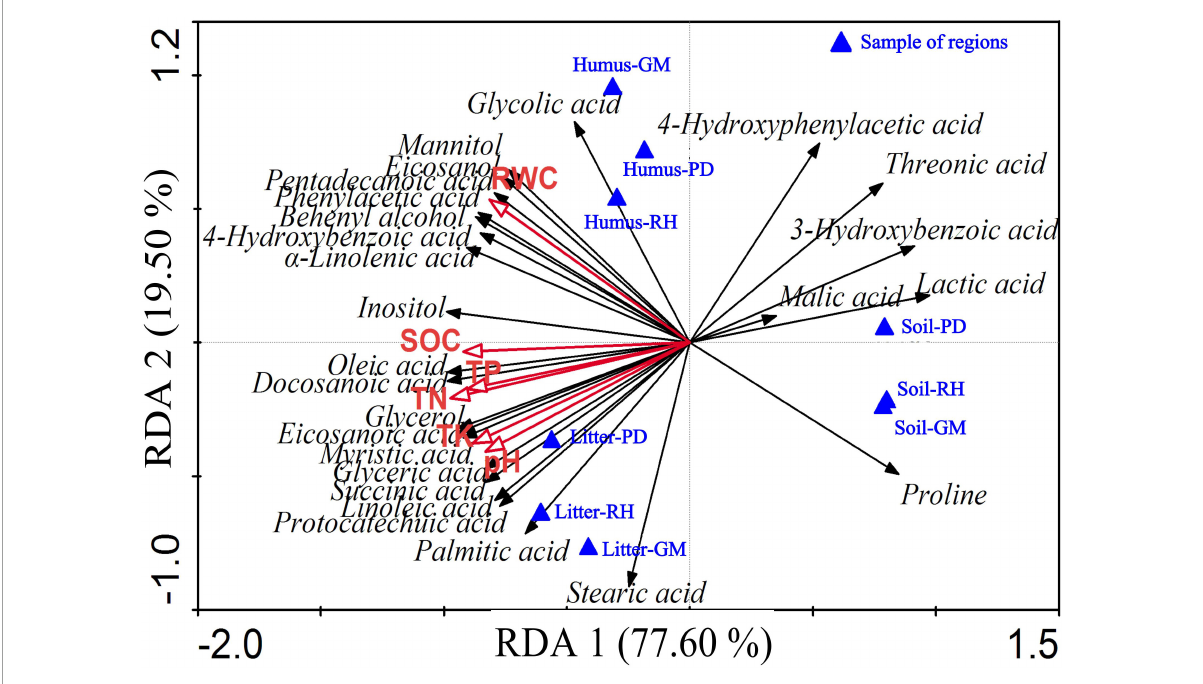
FIGURE3 Redundancy analysis between chemicals and soil layers. RWC, SOC, TN, TP, and TK denote relative water content, soil organic carbon, total nitrogen, total phosphorous, and total potassium, respectively; Renhe (RH), Pudi (PD), and Gamu (GM) denote the three regions.